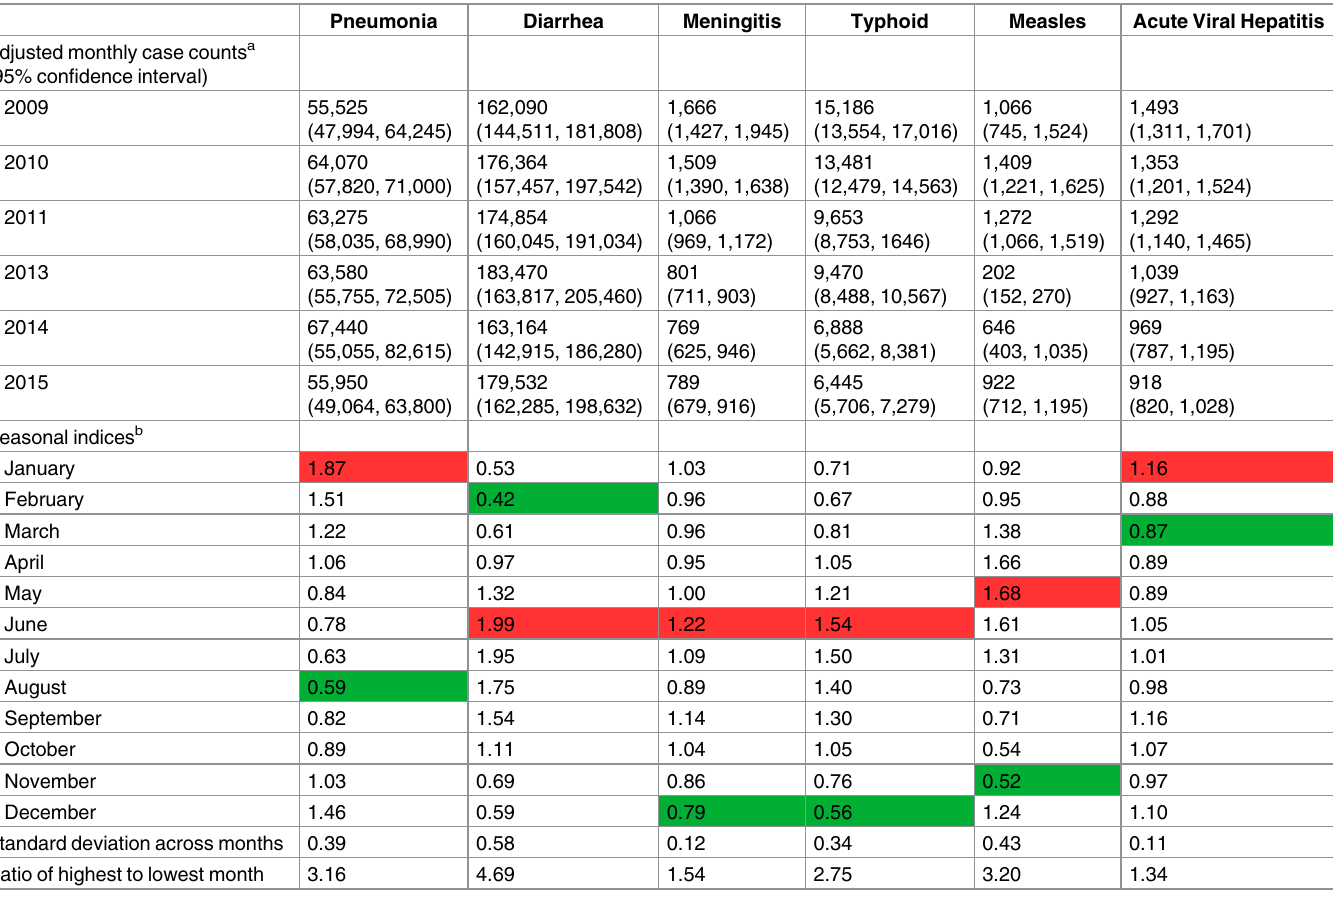
Table 3. Annual and seasonal trends for suspected cases of six diseasesfrom Afghanistan’s DiseaseEarly Warning System, 2009–2015.